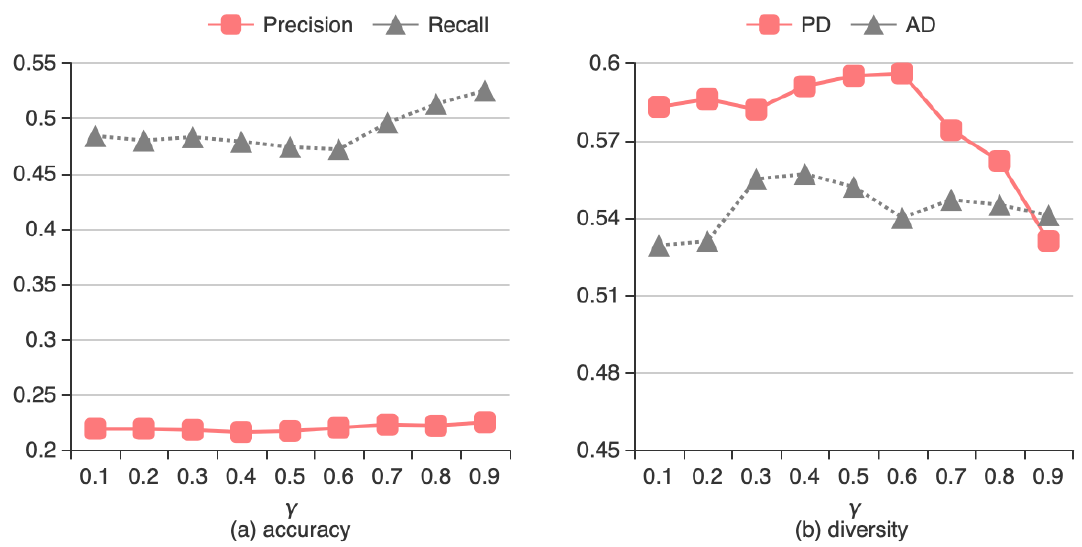
10 of 15 Figure 2. Effect of trust threshold θ on ( a ) accuracy and ( b ) diversity of Diversity Balancing for Two-Stage collaborative filtering (DBTS). We first examine the effect of trust threshold θ , ranging from 0 to 1 with increment of 0.1. Figure 2a shows the accuracy and Figure 2b the diversity of the DBTS algorithm for different values of θ . The optimal value of θ leads to the best performance in terms of accuracy and diversity . From Figure 2a we can see that θ has very little influence on either precision or recall. The highest accuracy happens when θ = 0.4. From Figure 2b we can see that the algorithm also has the highest diversity when θ = 0.4. Therefore, the optimal value of θ is set to 0.4.